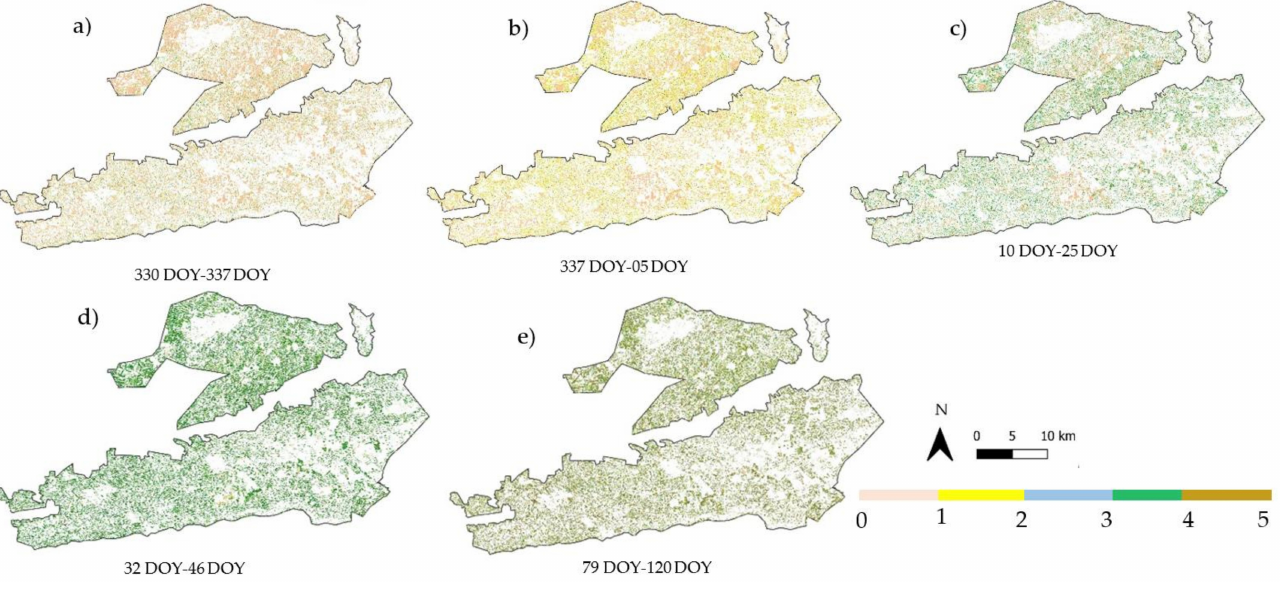
Figure 16. Maps of the five phenological stages of wheat for the TIP region deduced from Sentinel-1 (Model 7). The color bar represents the 0–1: germination, 1–2: tillering, 2–3: jointing, 3–4: heading, 4–5: maturity phases. Table 7. Estimated area of wheat phenological stages in the TIP region using Sentinel-1 (Model 7) and Sentinel-2 (Model 3): 0–1: germination, 1–2: tillering, 2–3: jointing, 3–4: heading, 4–5: